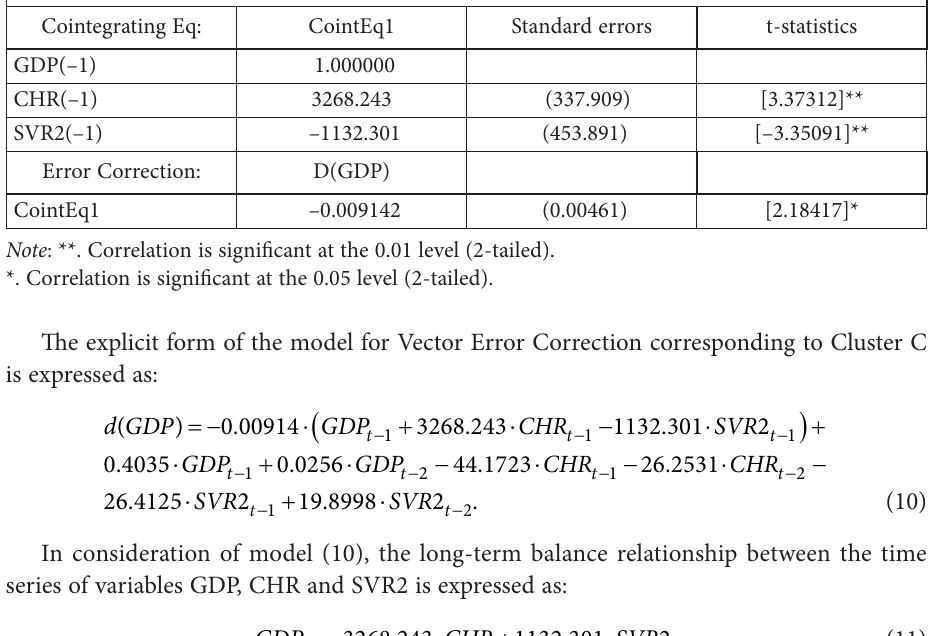
Table 16. Estimation of the cointegration model for Cluster C Vector Error Correction